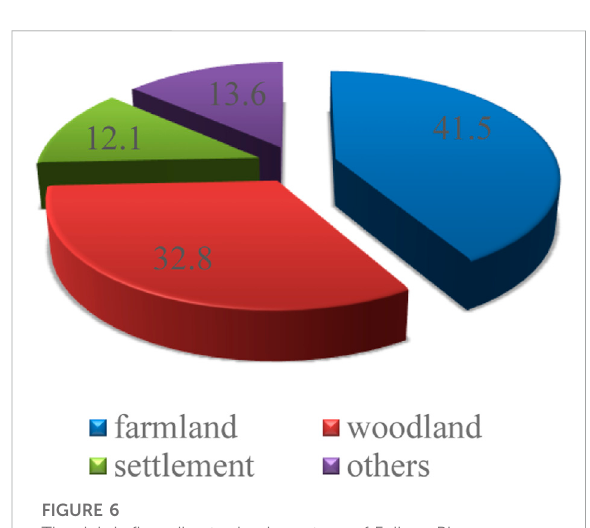
FIGURE 6 The debris fl ow disaster land-use type of Fujiang River